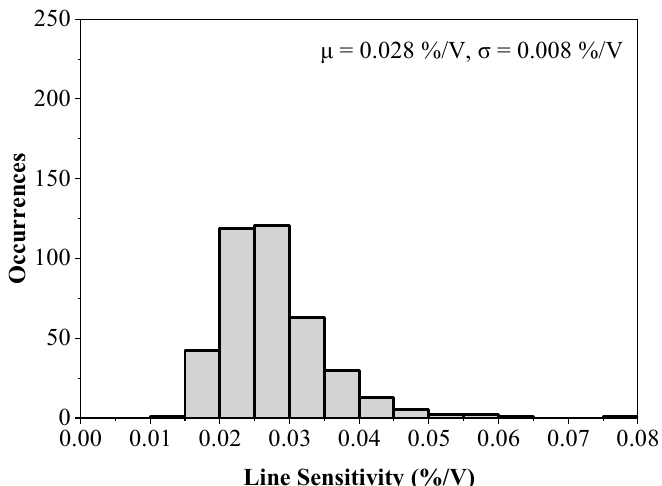
Figure 9. Normalized and magnified output voltages of the proposed design and the conventional 2-T reference.